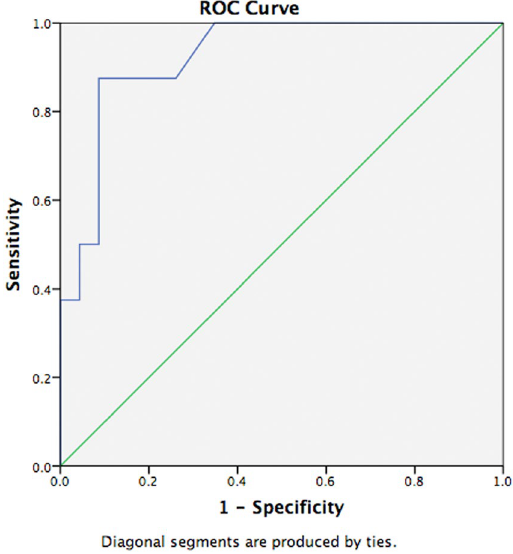
Figure 3. ROC curve of Kmean-post. The optimal Kmean-post threshold for distinguishing the RG from the NRG was 0.30, with 87.5% sensitivity and 91.3% specificity (AUC: 0.924; 95% CI,